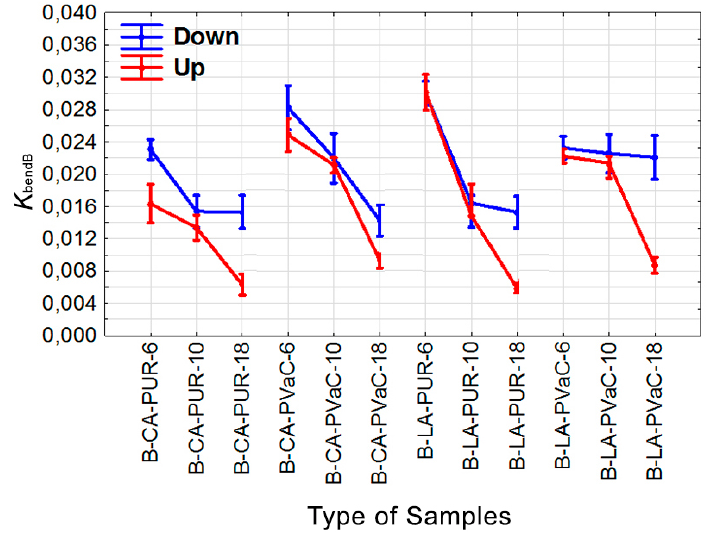
Figure 7. K bendB in case of beech.